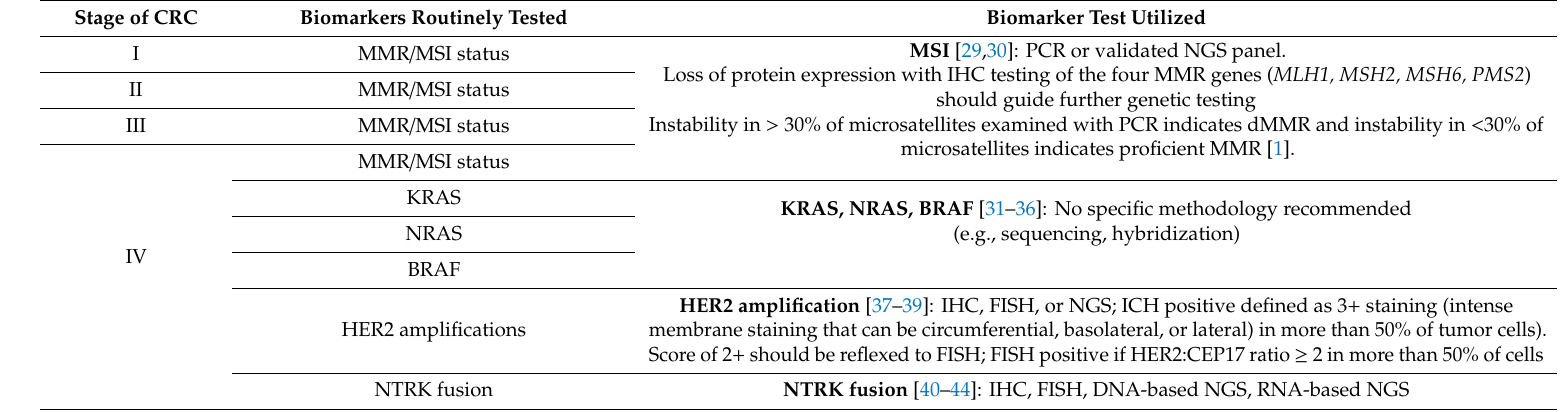
Table 1. Biomarker Testing Currently Recommended Based on CRC Stage.